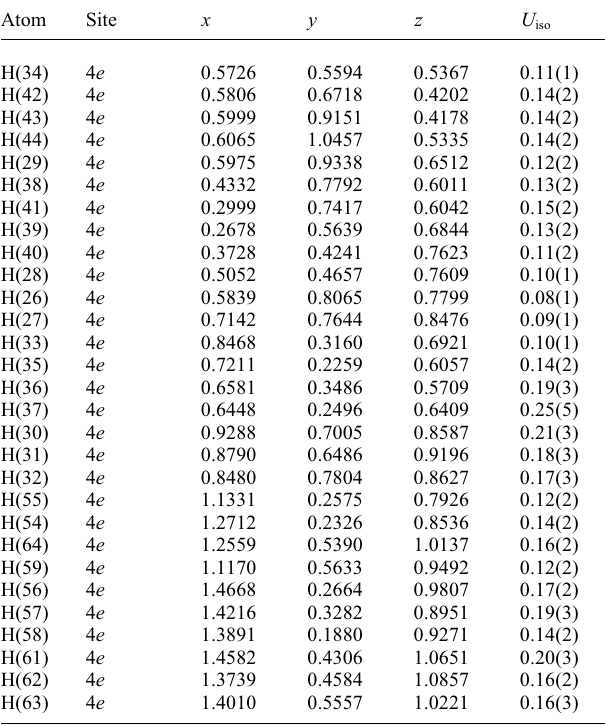
Table 2. Atomic coordinates and displacement parameters (in Å 2 )